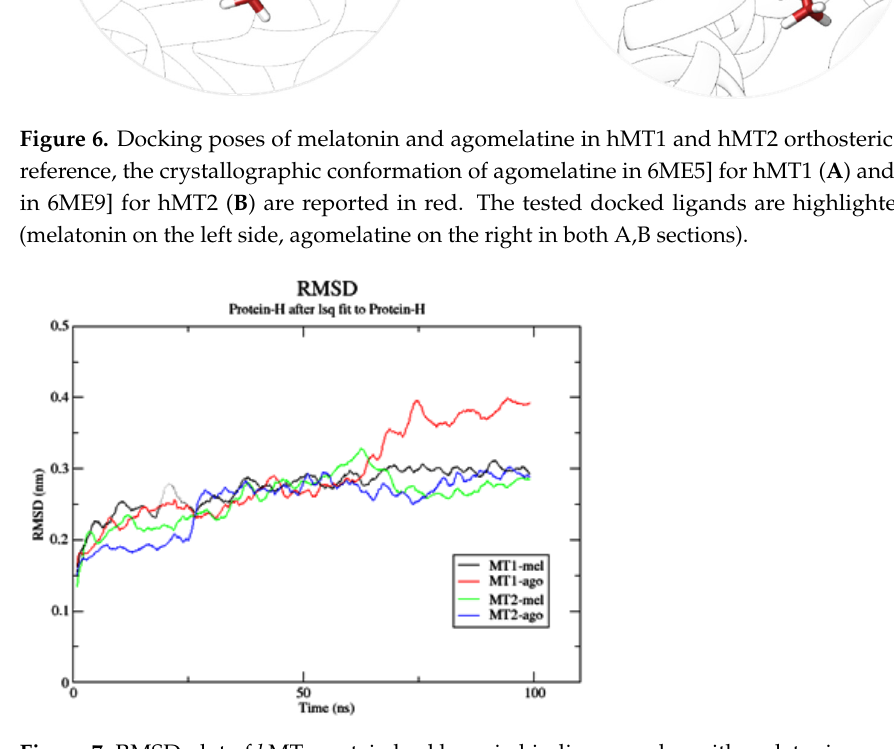
Figure 7. RMSD plot of h MTs protein backbone in binding complex with melatonin or agomelatine, in the function of